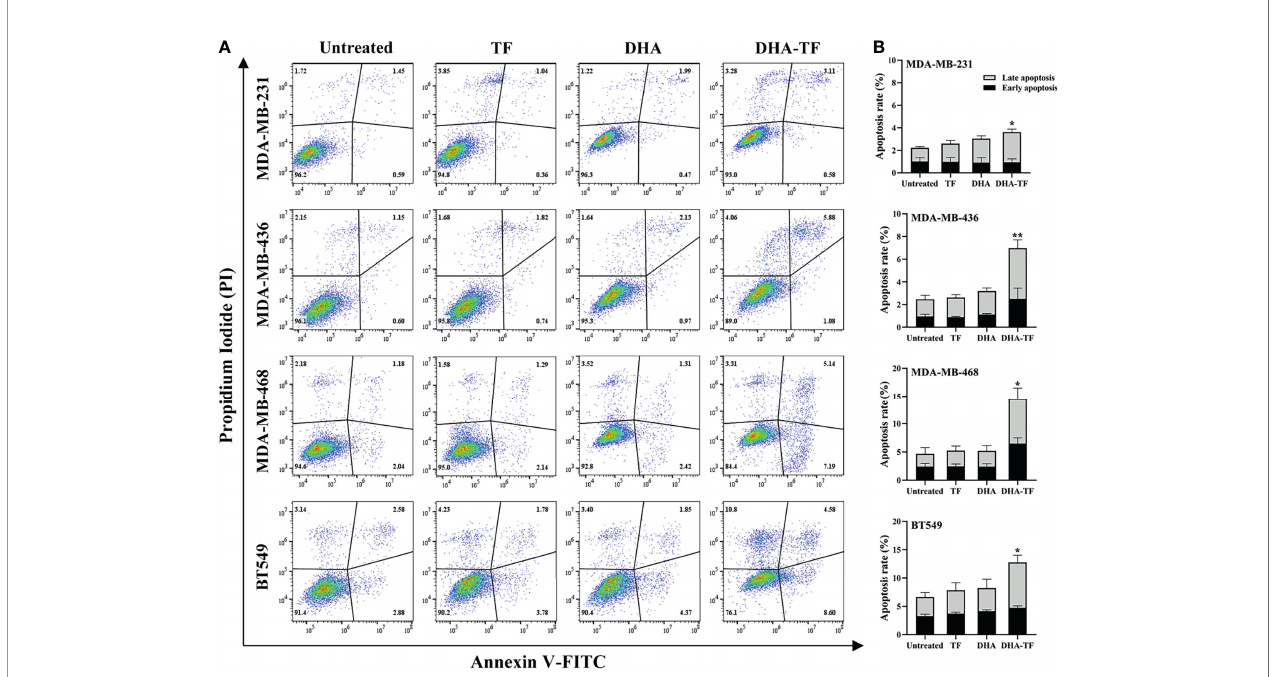
FIGURE 3 | DHA-TF adducts induce cell apoposis in TNBC cell lines. (A) TF, DHA and DHA-TF adducts were added to MDA-MB-231 (15 µM), MDA-MB-436 (15 µM), MBA-MD-468 (5 µM), and BT549 (5 µM) for 20 h. (B) Statistical analysis was based on three independent experiments. Apoptosis assay was performed by fl ow cytometry using annexin V/PI staining, and data were analyzed by FlowJo V10. p values were compared to untreated control. *0.01 < p ≤ 0.05, **0.001 < p ≤ 0.01.